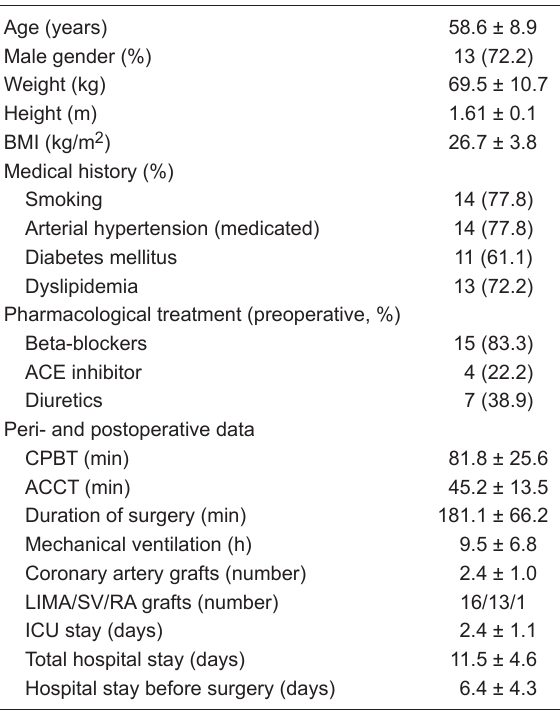
Table 1. Baseline, surgical and hospital data of the 18 patients